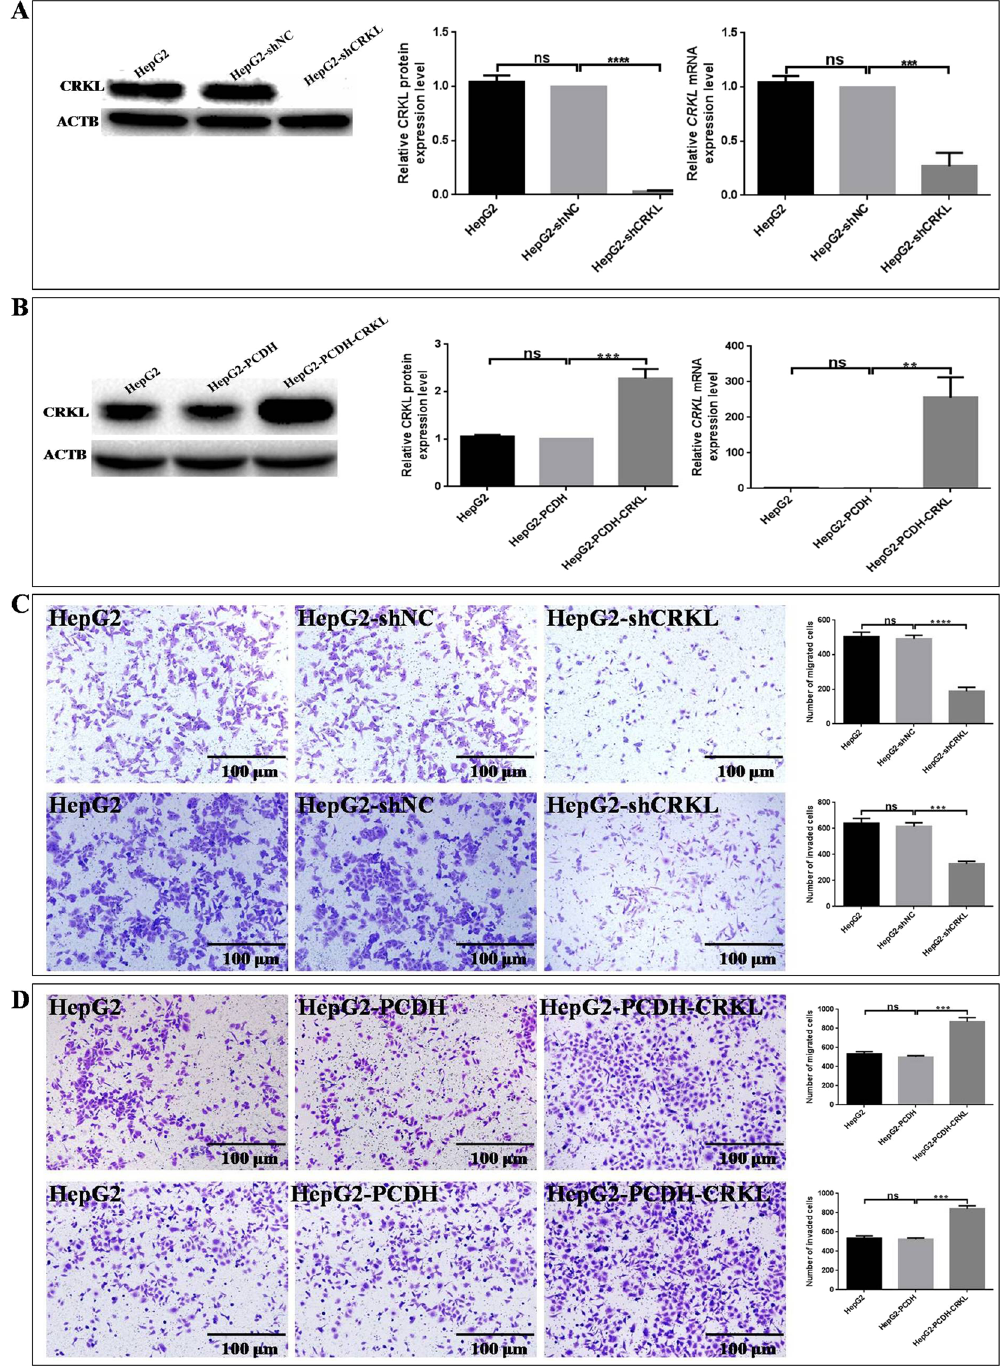
Figure 5. The effect of CRKL level on the in vitro migration and invasion abilities of HepG2 cells. ( A ) CRKL was down-regulated in HepG2. pGPU6/GFP/Neo-shRNA-CRKL and pGPU6/GFP/Neo-shRNA-NC were transfected into HepG2, selected against 400 μ g/ml G418. Relative mRNA and protein levels of CRKL were determined by qRT-PCR and WB using ACTB as internal reference. *** and **** refer to the P values of the differences < 0.001 and 0.0001, and ns refers to non stastical significance. ( B ) CRKL was up-regulated in HepG2 cells. PCDH-EF1-MCS-T2A-Puro-CRKL or PCDH-EF1-MCS-T2A-Puro were transiently transfected into HepG2 cells for 72 h. Relative mRNA and protein level was determined by qRT-PCR and WB using ACTB as internal reference. ** and *** refer to the P values of the differences < 0.01 and 0.001, ns refers to non stastical significance. ( C ) CRKL knockdown decreases and ( D ) CRKL overexpression enhances the in vitro migration and invasion capacities of HepG2 cells. *** and **** refer to the P values of the differences < 0.001 and 0.0001, ns refers to non stastical